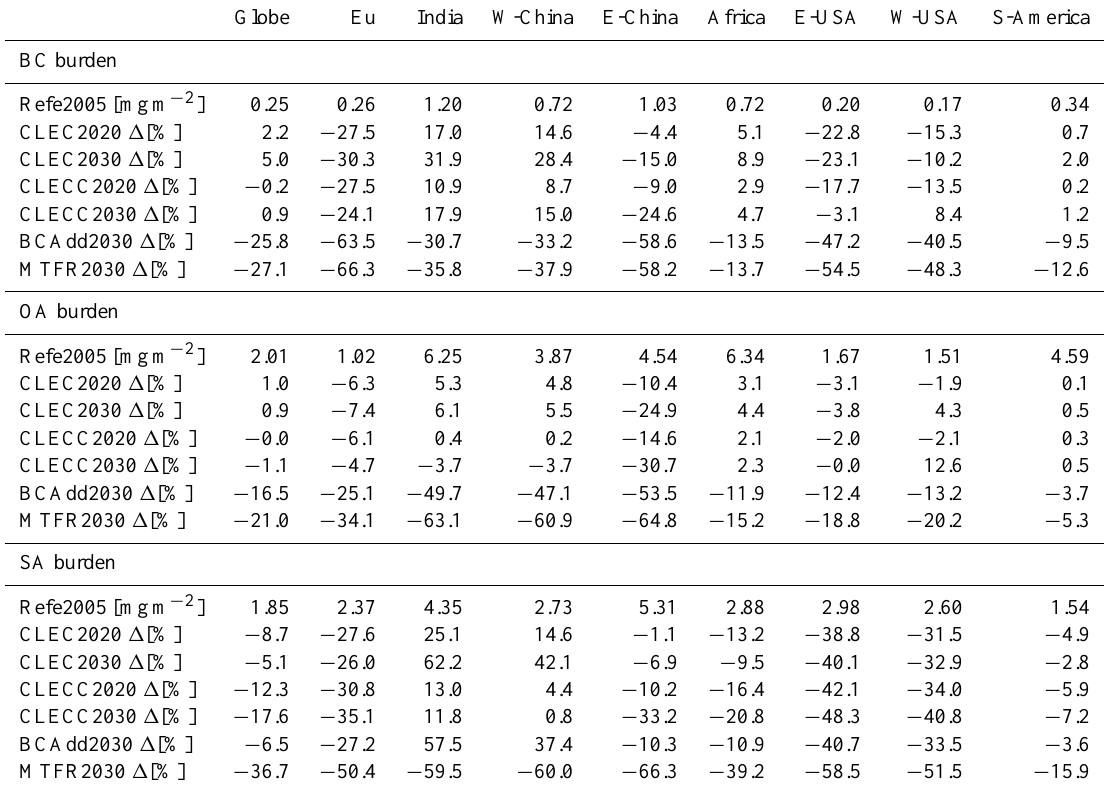
Table 2. The global and regional mean burdens of black carbon (BC), organic aerosols (OA) and sulfate aerosols (SA) for the reference simulation and the difference of the mean burden between the scenarios and the reference simulation. Globe